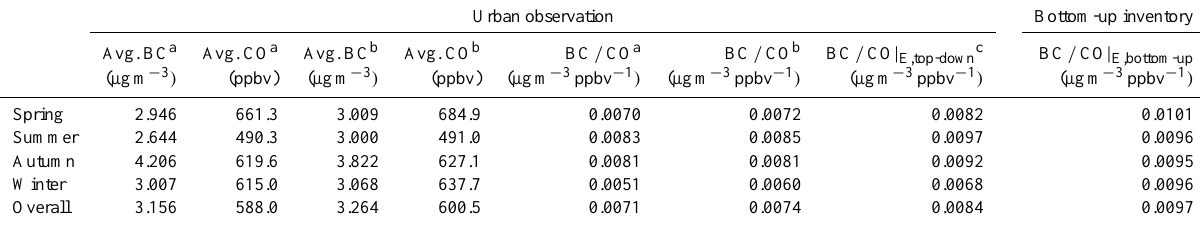
Table 2. The average concentrations of BC and CO and correlation of BC to CO from observations at Caochangmen and the ratios of bottom-up BC to CO emissions by season in Nanjing, 2012.